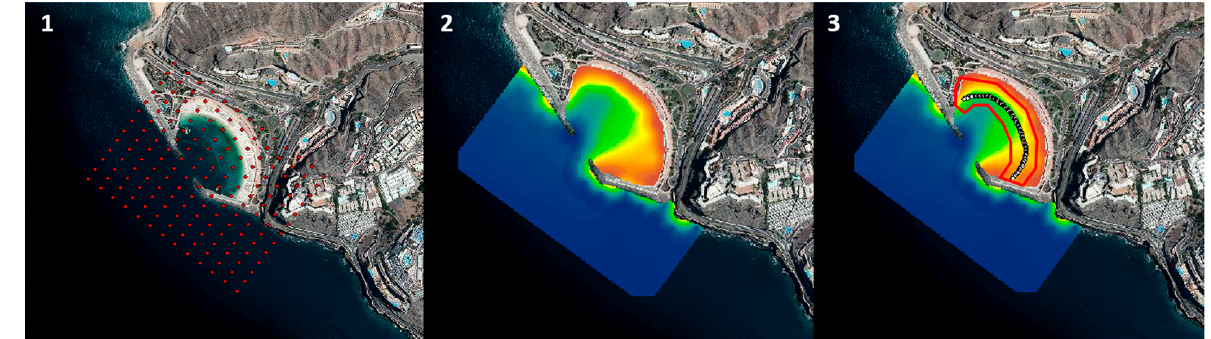
Figure 3. Example of the steps employed to calculate the flood sea level by SW sea storm events. ( 1 ) Mesh to interpolate Hs. ( 2 ) Raster obtained through Hs interpolation. ( 3 ) (red polygon), extraction of Hs values at elevation − 2 (considered as beach foot). Table 1. Digital surface models (DSMs) used in this research.